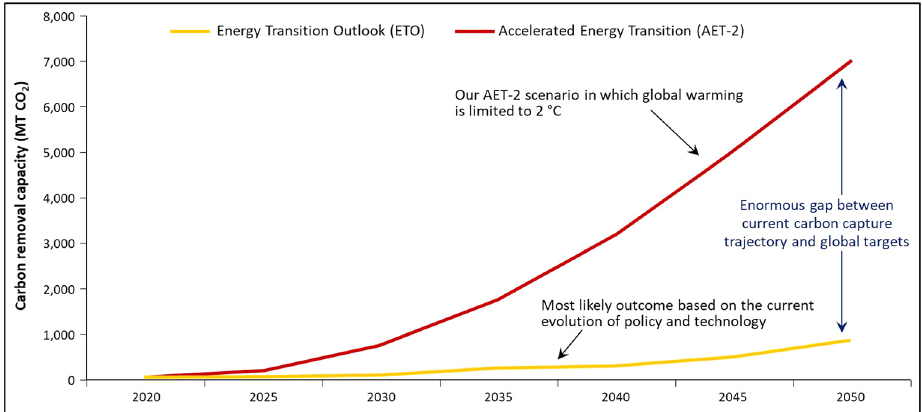
Fig. 8. – Comparison between carbon removal capacity needed for global targets and the current most likely scenario